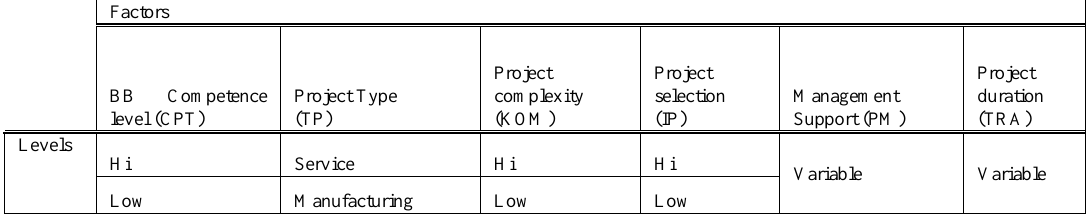
Table 2. Matrix: levels of input